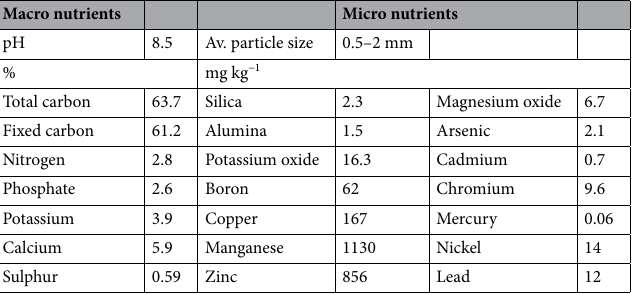
Table 1. Selected chemical properties of BlackEarth chicken litter biochar. Source : BlackEarth Company in North of Bendigo Victoria,